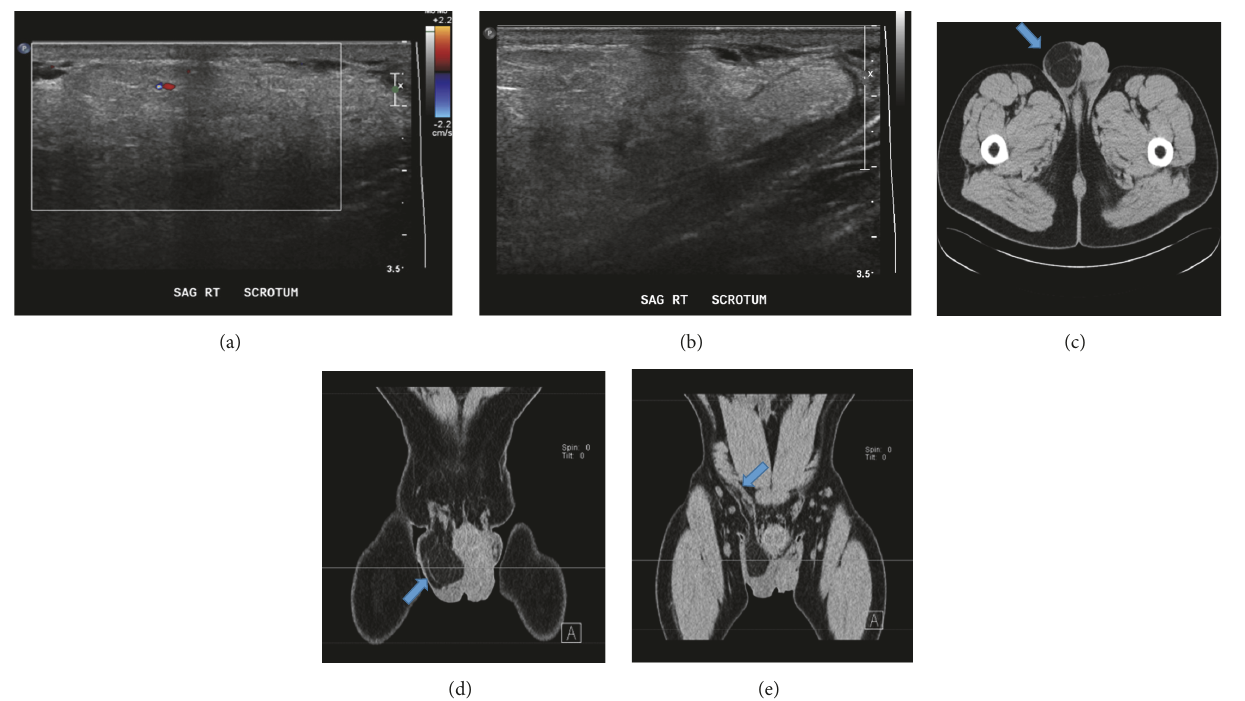
Figure1:Dopplerultrasoundincase1revealedahyperechoic,solid,andheterogeneouslesionwithminimalflow(a),extendingtothescrotum (b). CT imaging in case 2 showed a low density mass with septations in the right scrotal sac ((c), axial view). The bulky mass was compressing the testicle ((d), coronal view) and showed spread into the abdominal cavity through the inguinal canal ((e), coronal view, arrow).